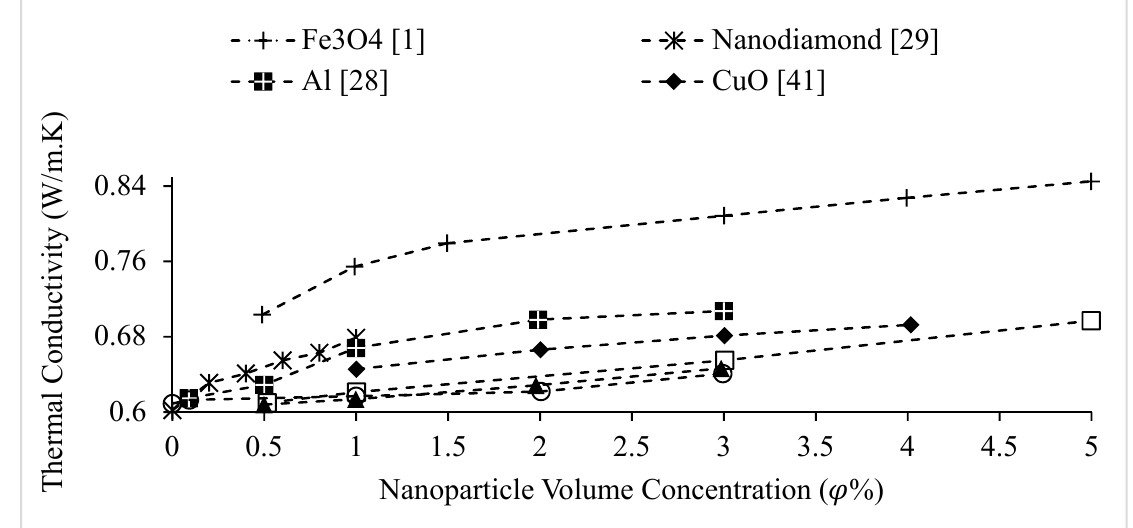
Figure 4. Variation of water-based nanofluid thermal conductivity as a function of nanoparticle volume concentration, 𝜑 , for different nanoparticles at room temperature.